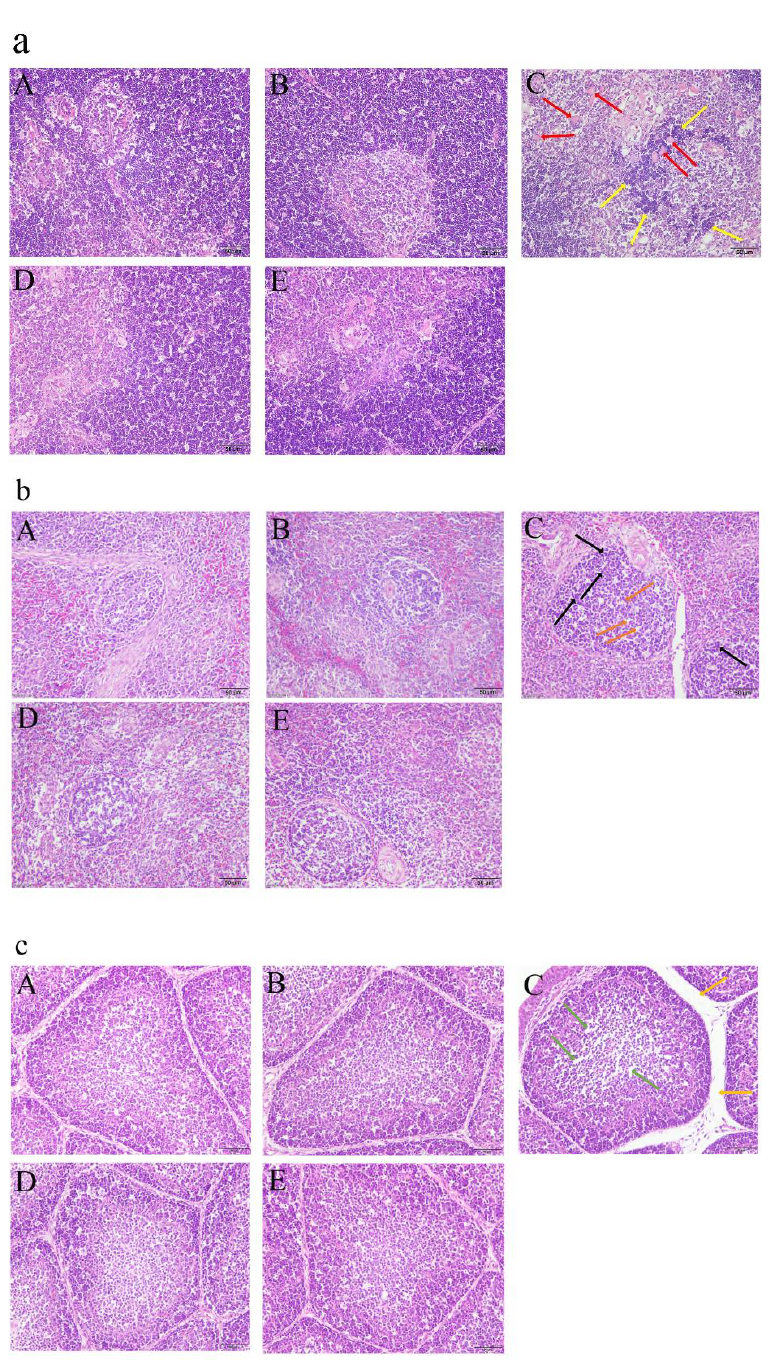
Figure 3. GA alleviated MG-induced immune organ damage in the broilers. ( a ) GA alleviated MG- induced thymus damage. Yellow arrows show inflammatory cells’ infiltration and red arrows show vacuoles in the cortex and medulla of thymus. ( b ) GA alleviated MG-induced spleen damage. Orange arrows shows lymphocytes’ shedding and black arrows show mononuclear hyperplasia. ( c ) GA alleviated MG-induced bursa of Fabricius damage. Green arrows show lymphocytes’ shedding and golden arrows show increased space between bursal follicles. A: control group, B: GA-alone treatment group, C: model group, D: Tia therapy group, E: GA therapy group.